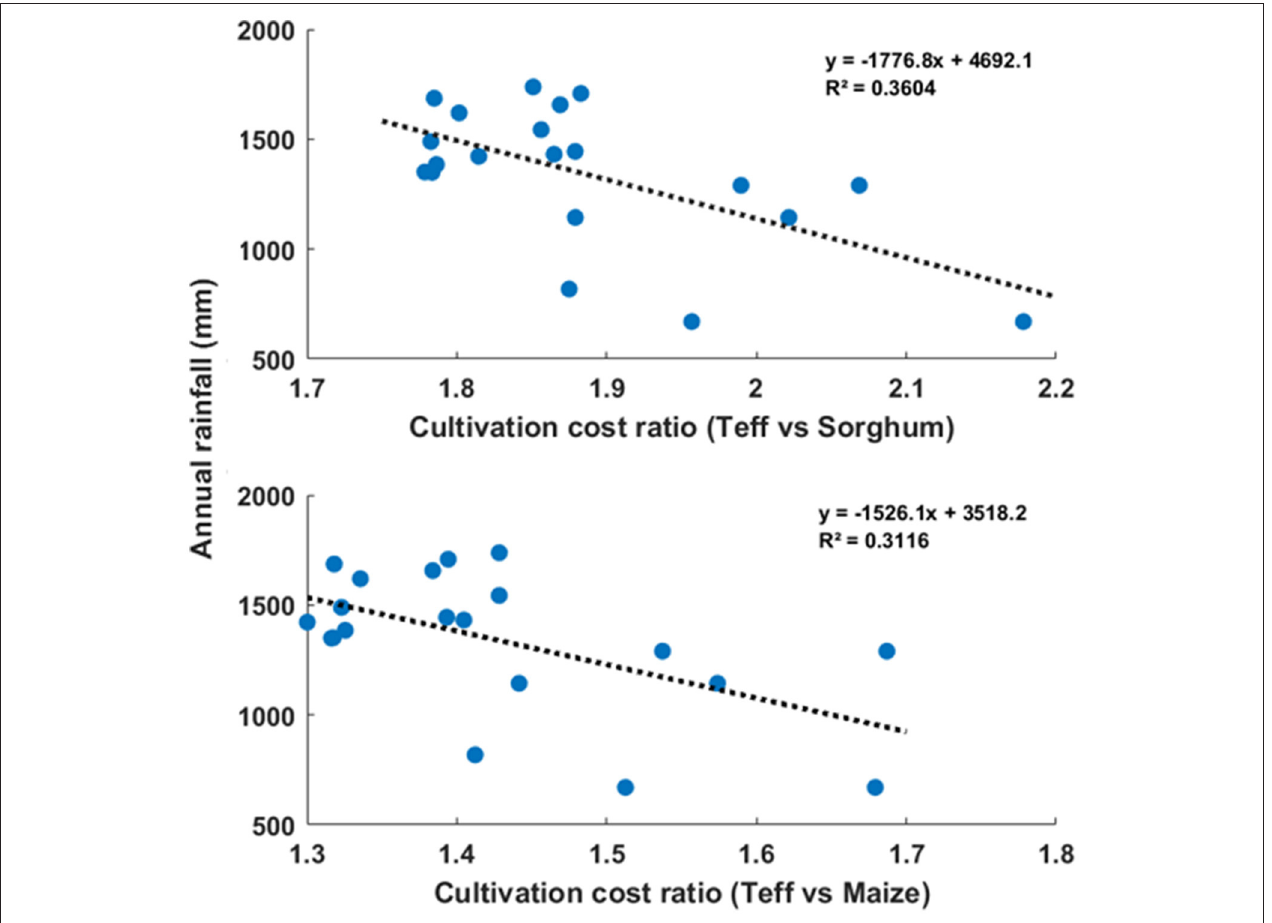
FIGURE 10 | Scatter plots of cultivation cost ratios of teff and maize, and teff and sorghum, vs. rainfall. Cultivation cost of Teff relative to the other two crops falls when rainfall